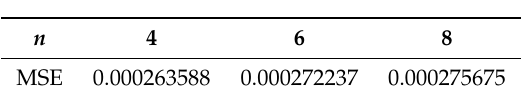
Table 6. n selection for MU.